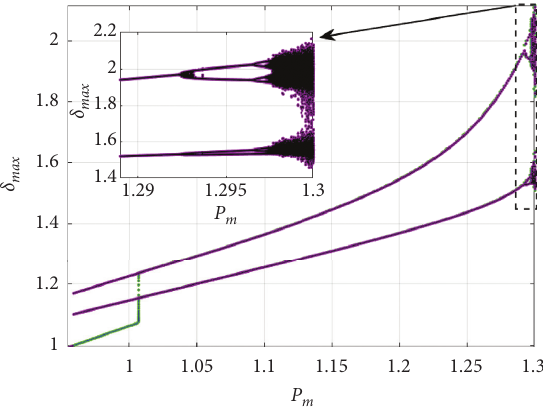
Figure 7: Bifurcation diagram for fractional-order power system